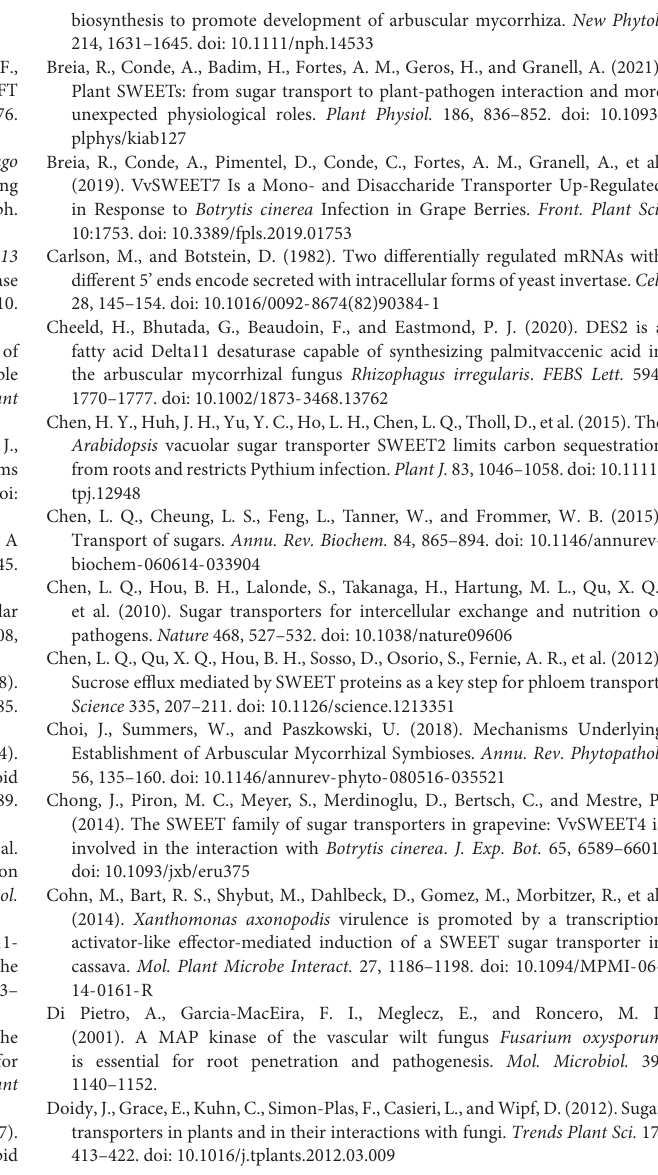
Supplementary Figure 1 | Ectopic expression of StSWEET7a in roots modifies plant architecture and survival after transplanting. (A) Relative expression of StSWEET7a ( StSw7a ) normalized to StActin was measured by qRT-PCR in roots of composite plants grown under two mycorrhizal conditions (Myc − , Myc + ) and under two different experimental conditions (Exp1 and Exp2). Statistical